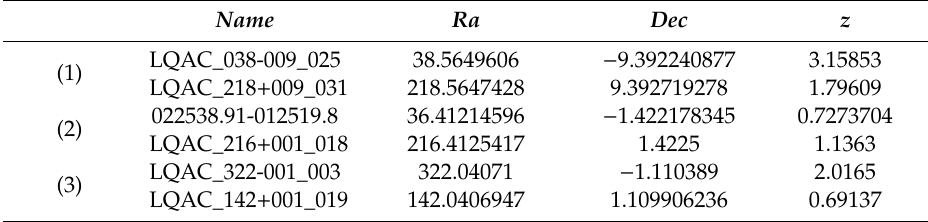
Table 17. Pairs of opposite quasars from the KQCG catalog [48] as candidates for the cosmic mirror e ff ect with the best positional accuracy—alternative approach. Accuracy is of 0.0005 ◦ for ra and dec and z / 2 for z